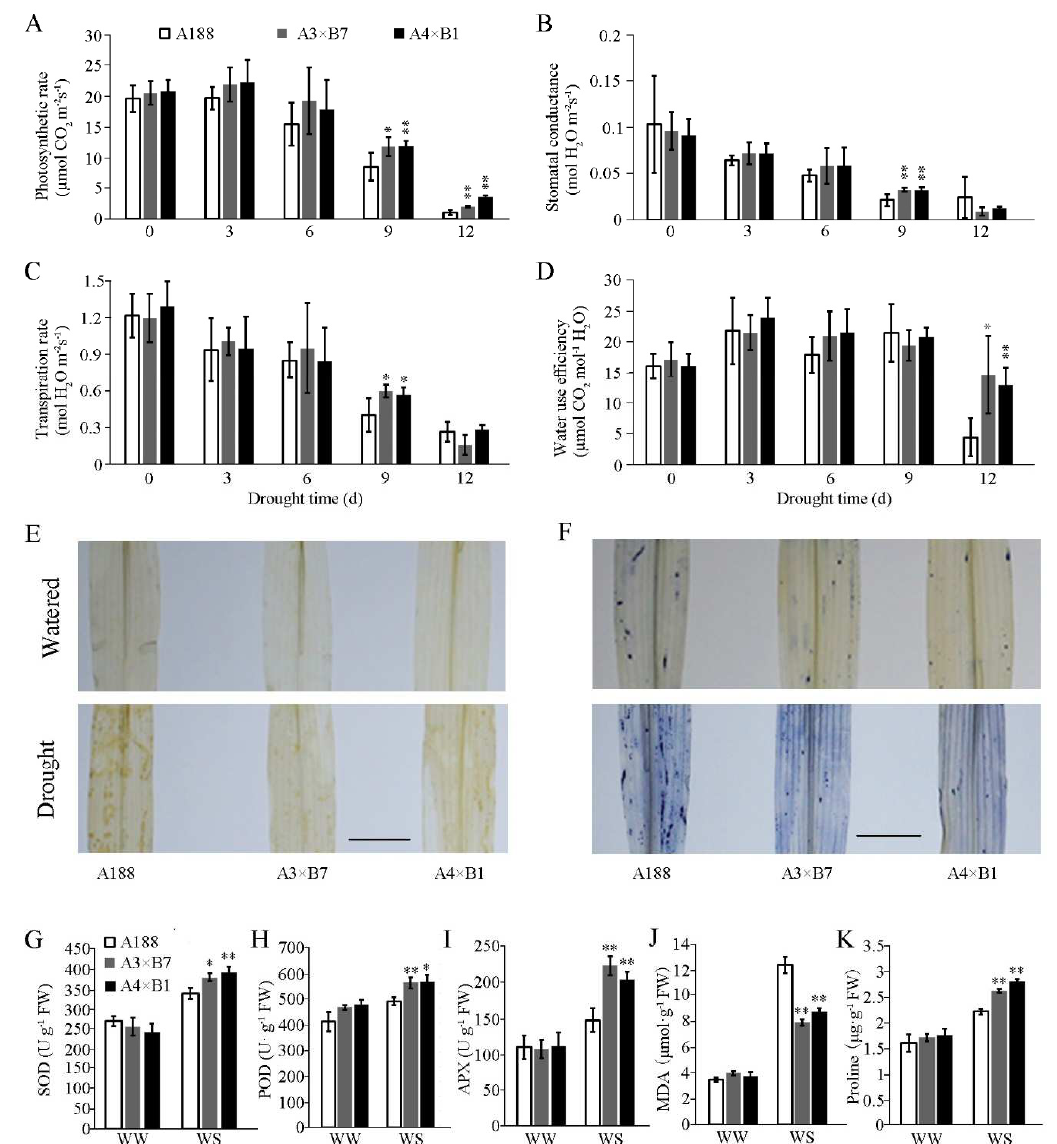
Figure 2. Photosynthesis rates and antioxidant enzyme activities in transgenic and WT maize seedlings in the greenhouse. ( A ) Photosynthesis rate, ( B ) stomatal conductance, ( C ) transpiration rate, and ( D ) water-use efficiency were compared over 12 days of drought stress. ( E ) DAB staining to detect H 2 O 2 levels in leaves of well-watered or drought-treated transgenic and WT plants at day 12 of treatment. ( F ) NBT staining to detect O 2 − production in leaves drought-treated or well-watered transgenic and WT plants at day 12 of treatment. The leaf samples were used to detect ( G ) SOD activity, ( H ) POD activity, ( I ) APX activity, ( J ) MDA content, and ( K ) proline content. WW, well- watered; WS, water stress. Bar = 1 cm. Data were obtained from three independent tests with no less than 18 seedlings per genotype. Data are the average of three independent tests ± s.d. (* p < 0.05, ** p < 0.01; two-sided t